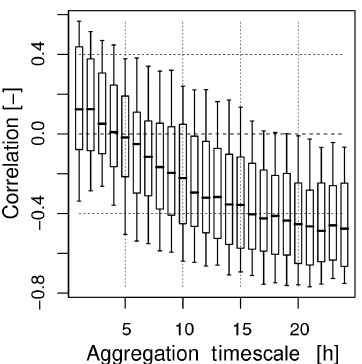
Figure 10. Box plots of Spearman rank correlation between the 95th rainfall quantile and intermittency (over temperature) as a function of timescale. Each box plot shows the 10, 25, 50, 75 and 90% quantiles of all 99 stations in the dataset.